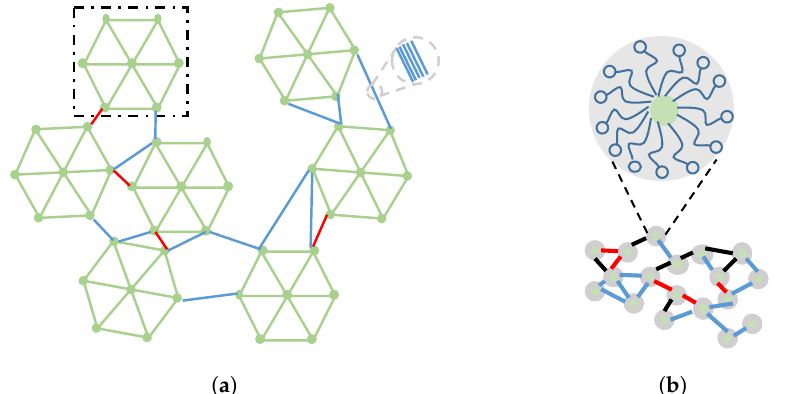
Figure 1. Schematic representation of the dual cross-linked network: ( a ) Hexagonal particles, which can establish strong (black) and labile (blue) bonds with their neighbors; ( b ) Spherical particles, surrounded by a corona of distributed reactive polymer chains that establish bonds with their neighbors. Colors may indicate the type of bond and/or the number of bonds between the connected